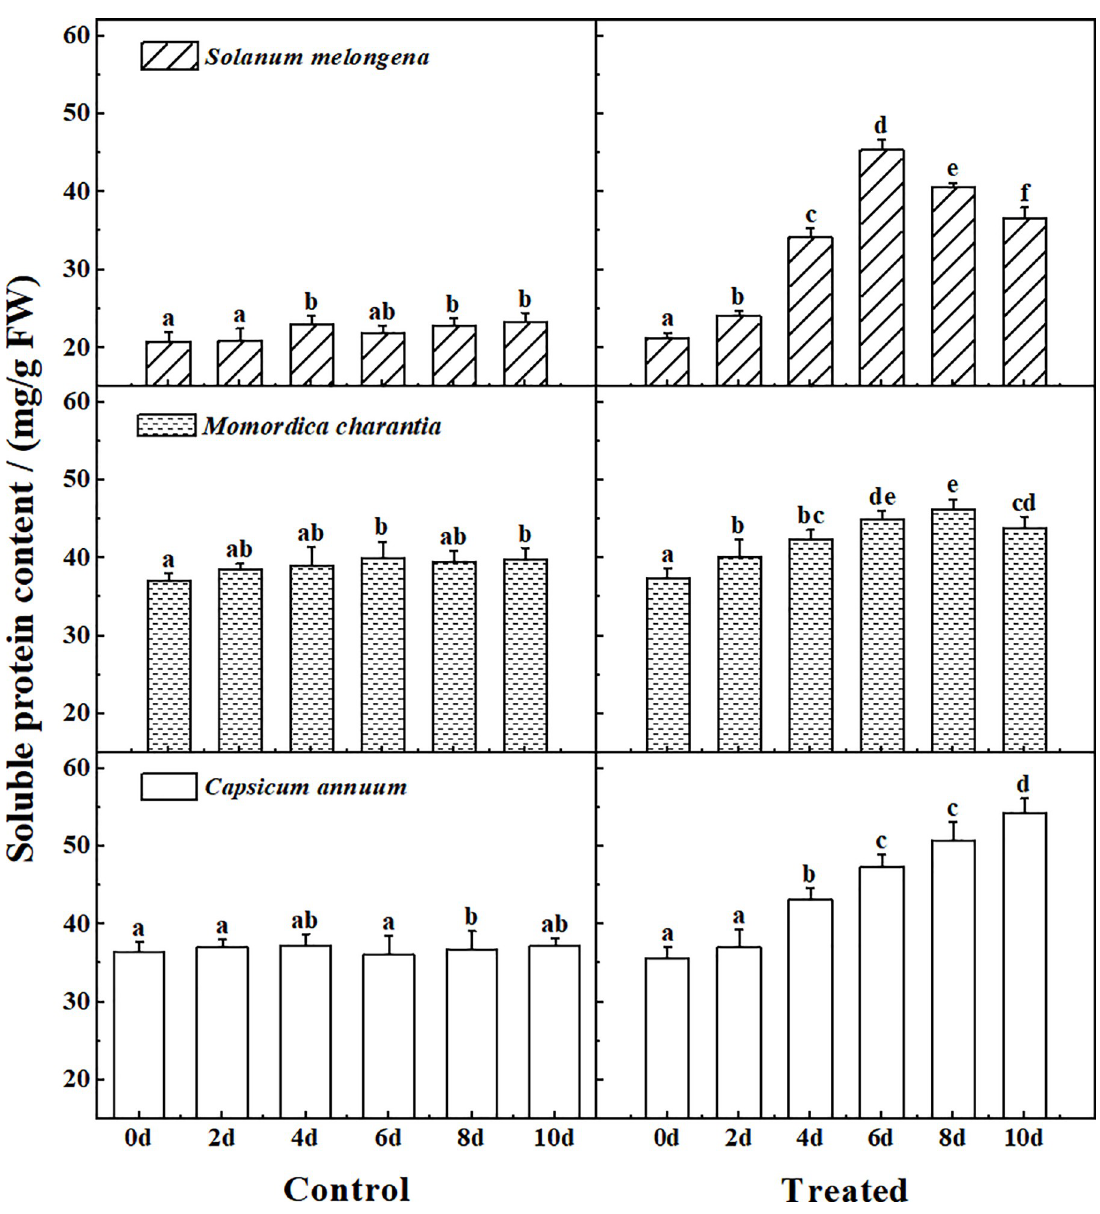
Fig 2. The response of soluble protein to normal watering (Control) and salt water irrigation (Treated) in Solanum melongena , Momordica charantia , Capsicum annuum . The single salt solution (NaCl, 150 mmol/L) was watered once a day (25 ml per pot) for a total of 10 days, seedling leaves were randomly sampled every 2 days to determine the soluble protein content. Error bars represent standard errors of soluble protein content with 4–5 replicates measurements. The same letter in each picture represents no significant difference (Duncan test, P < 0.05, n = 4–5).